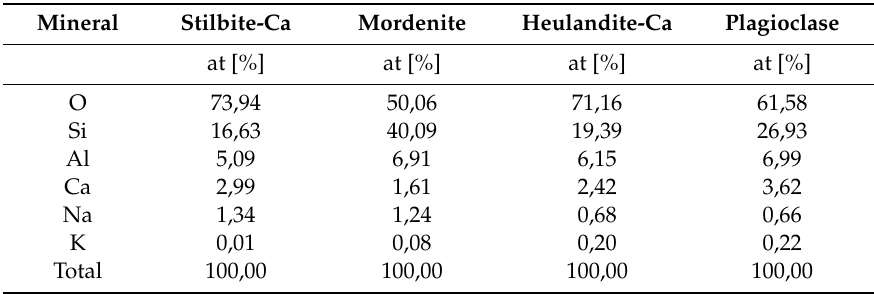
Table 7. EDX data of stage II zeolites and plagioclase of sample JAM 10—stilbite-Ca, mordenite, heulandite-Ca, plagioclase; the slight deviations from the theoretical stoichiometric compositions